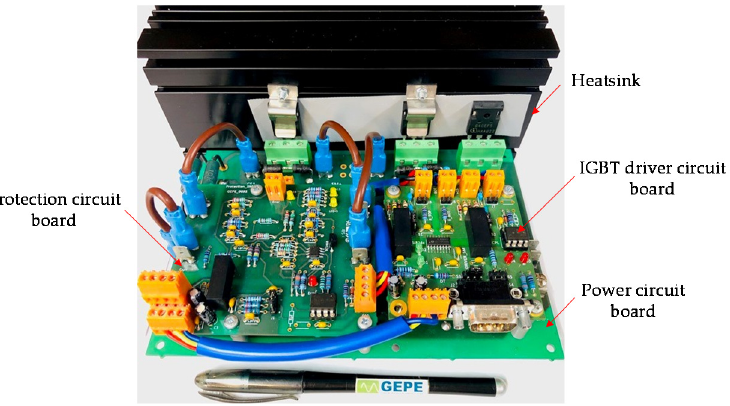
Figure 11. Final submodule (SM) structure.